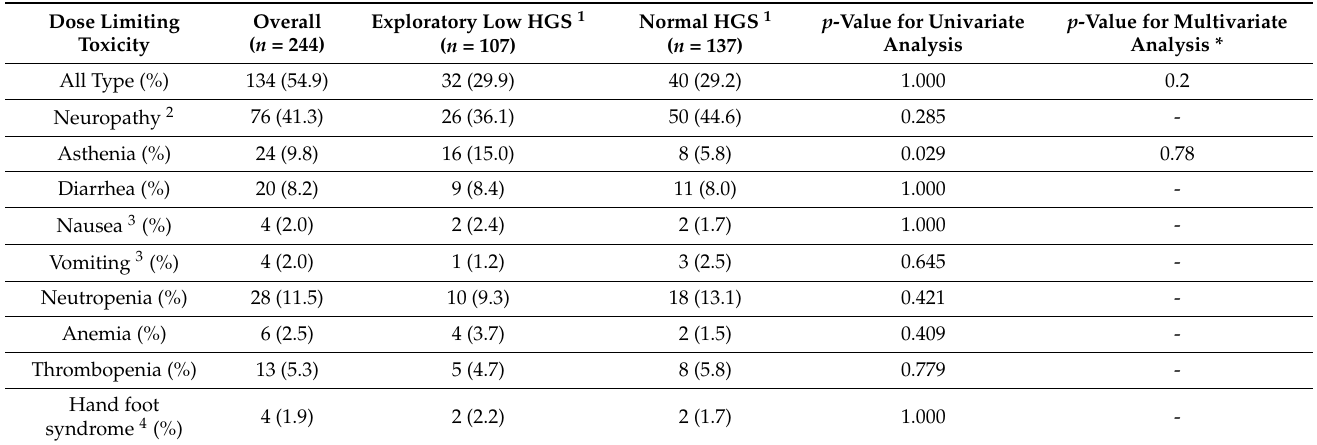
Table 3. Association between low handgrip strength on median-based analysis (exploratory low HGS) and chemotherapy-induced dose-limiting toxicity (DLT).